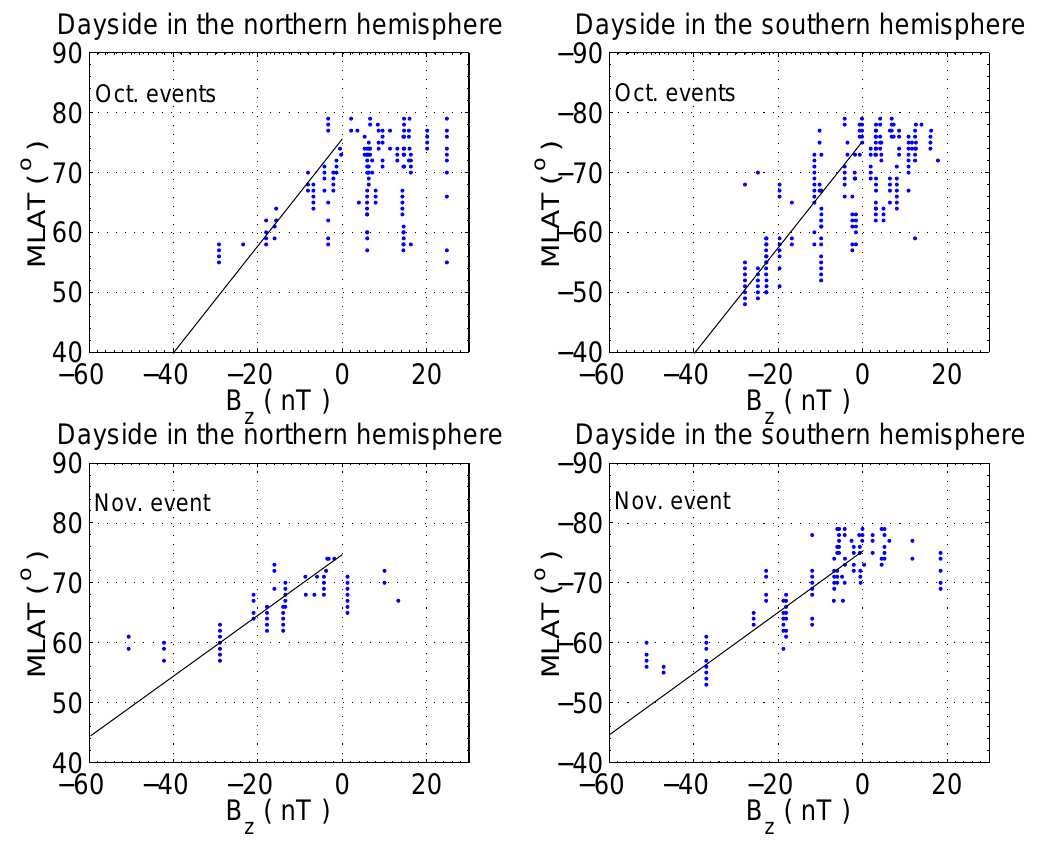
Fig. 10. Scatter plots of the latitudes versus B z for intense FACs density of the October and November events. The black lines represent the scaling between southward IMF Bz and MLAT of FACs used in Figs. 4 and